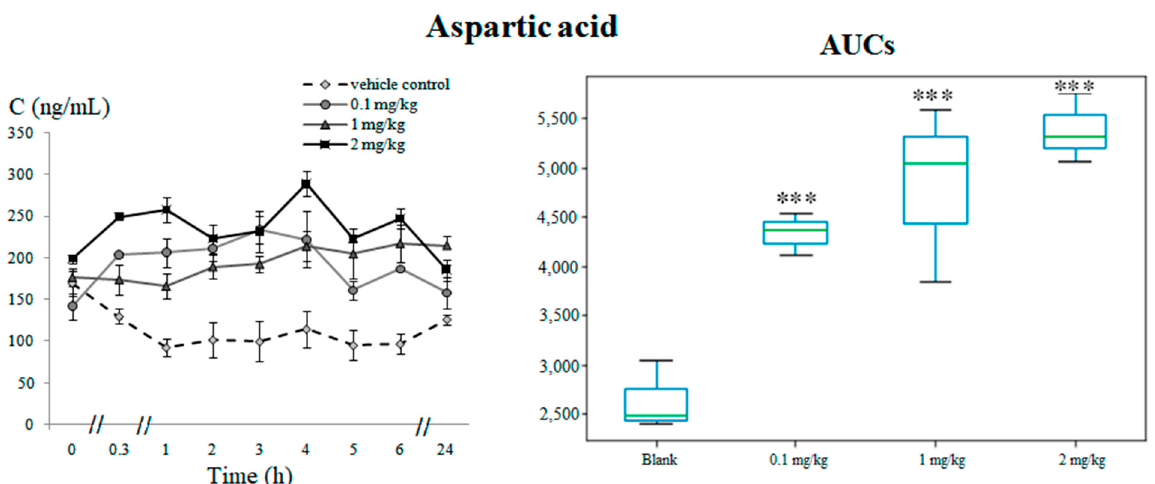
Figure 3. Aspartic acid, a metabolite related with the aspartic acid innervation system. Statistically significant differences in the AUCs between the vehicle control versus the test groups are marked with asterisks as *** p < 0.001.